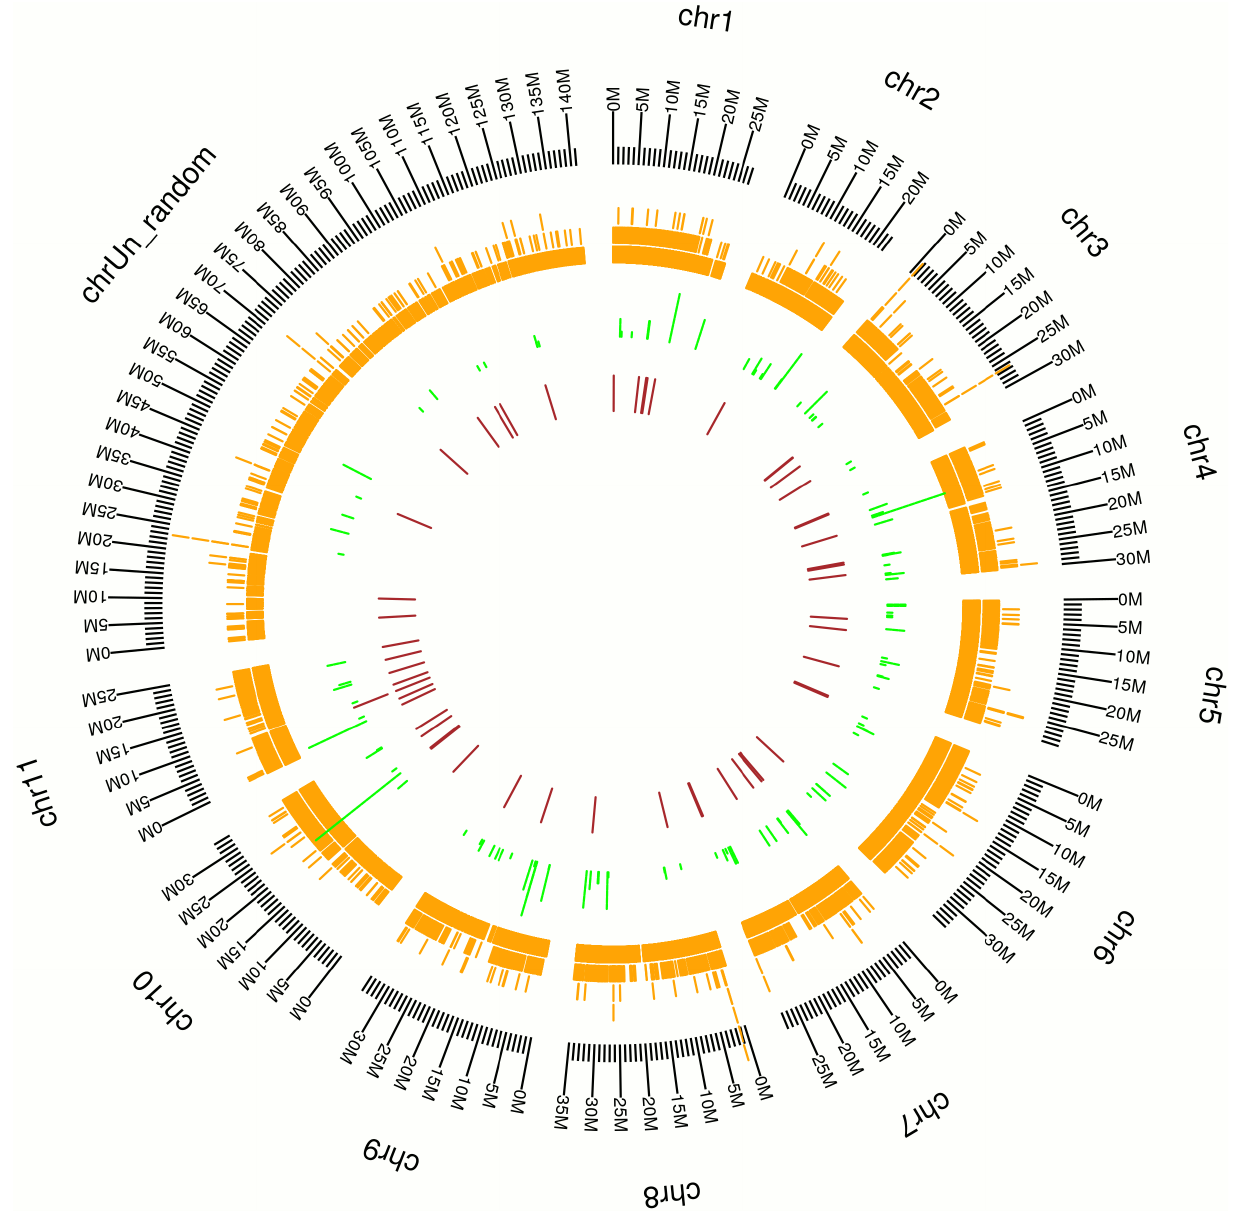
Fig 1. Distribution of expressed transcripts on a reference Musa Genome [18]. Black (outer ring): chromosomes of the reference Musa A-genome, scale in Mb; orange: de novo assembled unigenes; green: orthologous microRNAs; maroon: Musa -specific microRNAs.